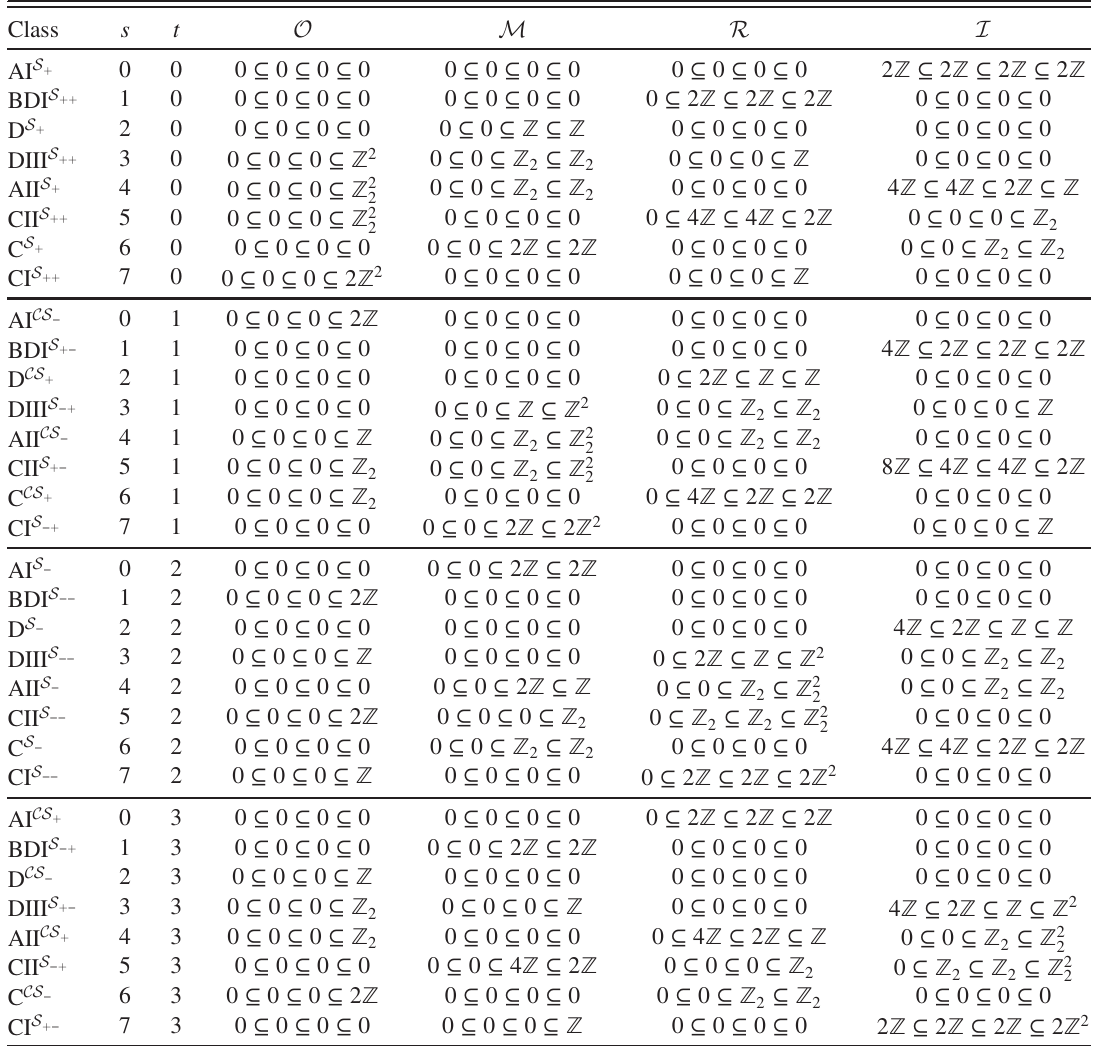
TABLE VII. Bulk classification sequence (1) for three-dimensional topological crystalline phases with an order- two crystalline symmetry or antisymmetry for the real tenfold-way classes. The symbols O , M , R , and I refer to local on-site ( d ¼ 0 ), mirror ( d ¼ 1 ), twofold rotation ( d ¼ 2 ), and inversion symmetry ( d k k k